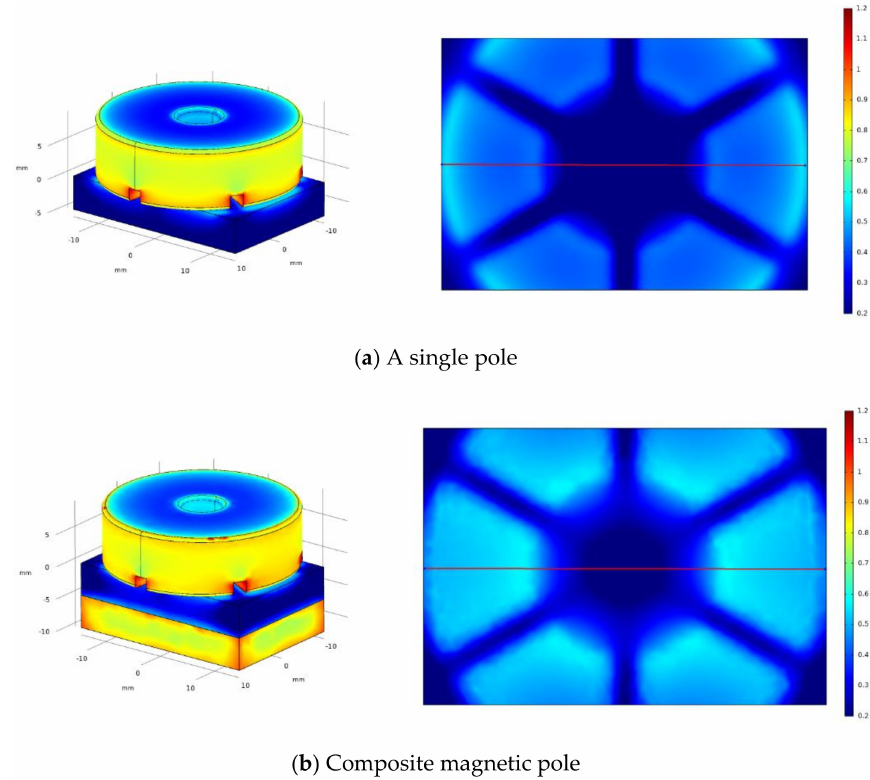
Figure 4. Simulation diagram of magnetic induction intensity of two MAF methods.